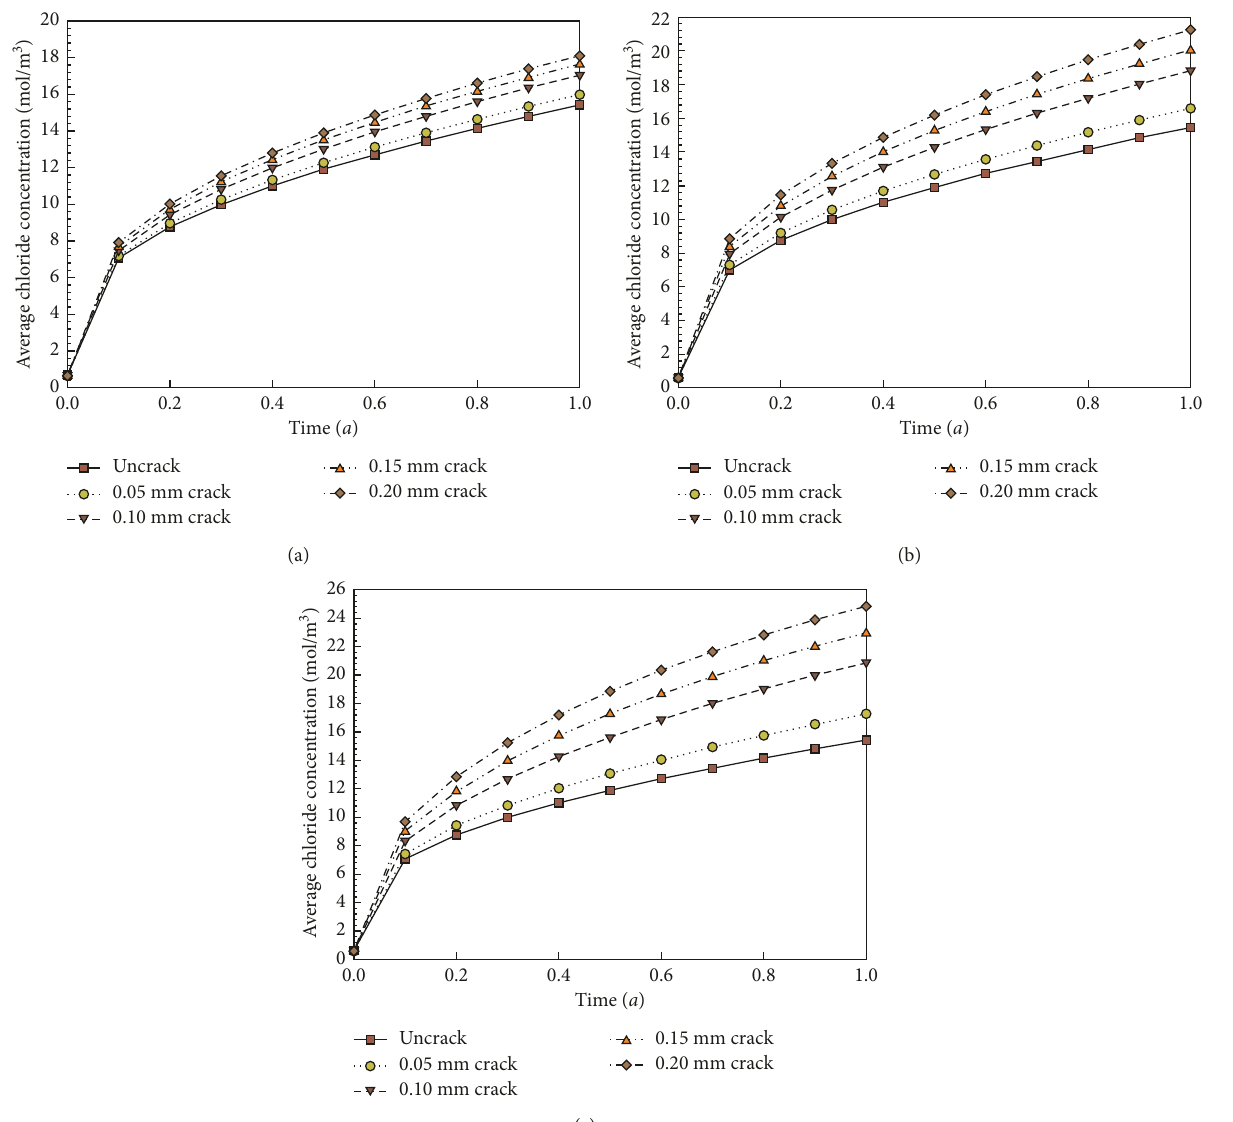
Figure 12: Comparisons of average chloride concentration on the surface of the rebar between models (different crack widths and quantities). Crack quantity: (a) 1, (b) 2, and (c) 3.